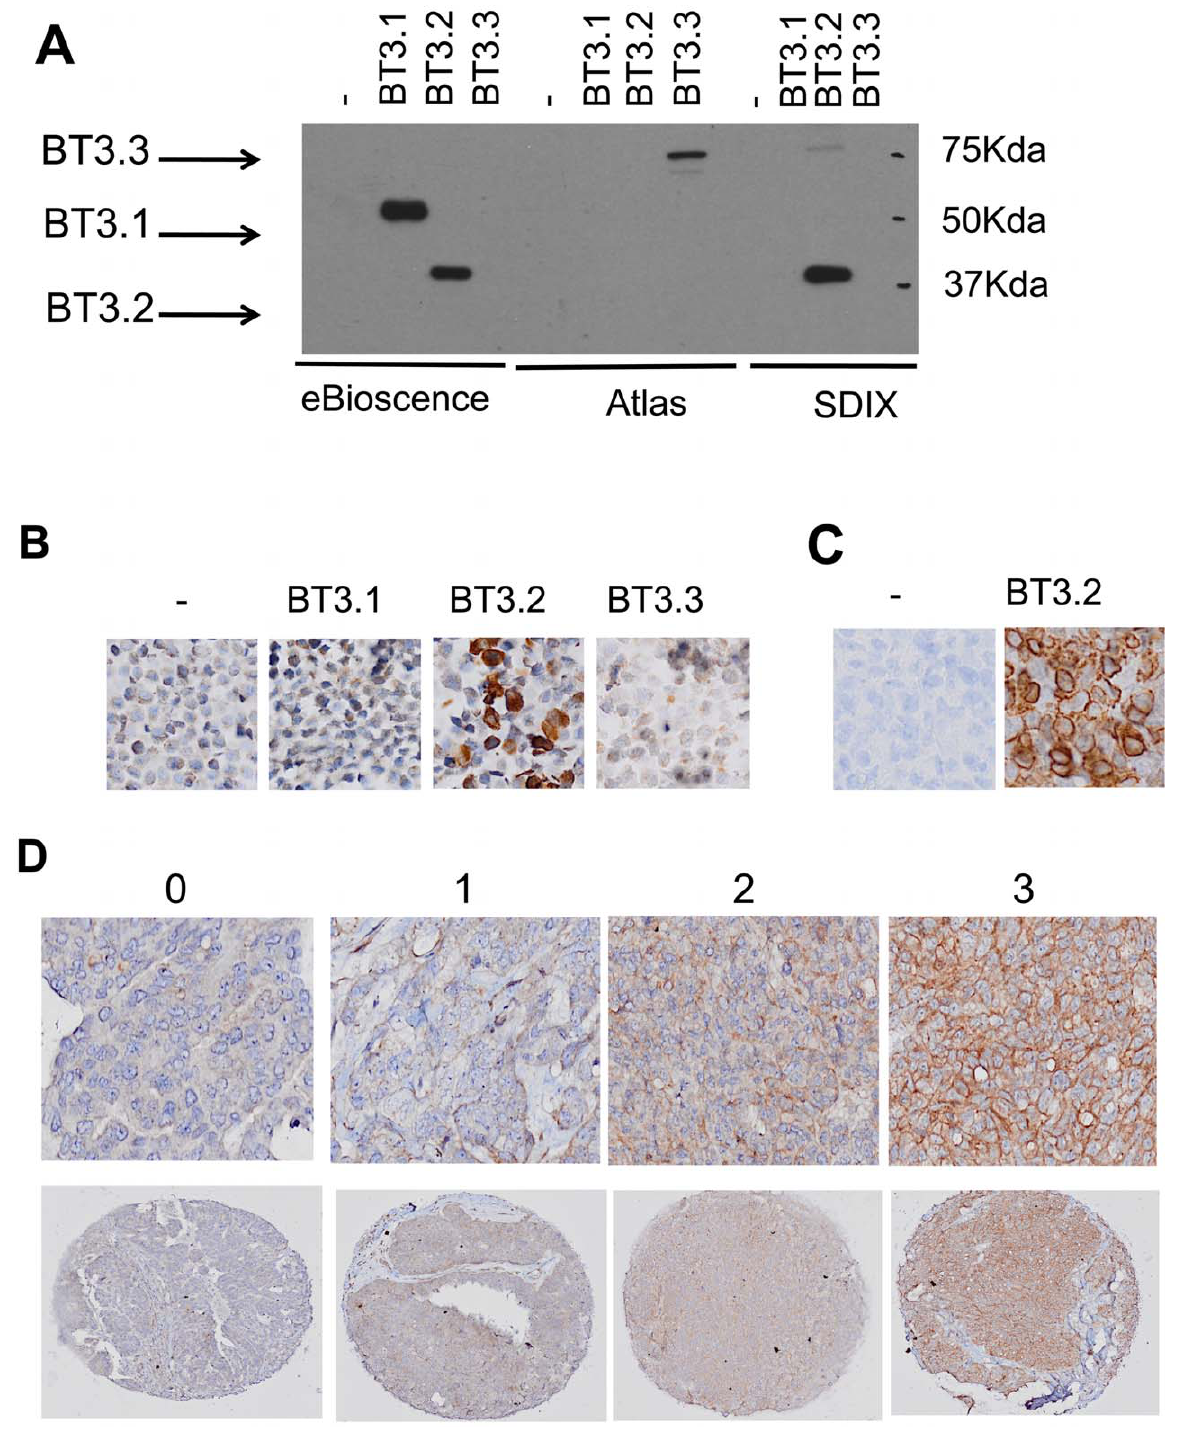
Figure 1. BT3.2 expression in ovarian cancer cells. A . Western-blot analysis of total protein extracts from TOV112D cell line infected with PLenti (vector control), BT3.1, BT3.2 or BT3.3 viral constructs. Extracts were loaded in triplicate on 10% SDS/PAGE gel and membranes were hybridized with anti-CD277 (eBioscience), anti-BT3.3 (Atlas Antibodies) and anti-BT3.2 (SDIX Inc.) as indicated at the bottom of the Figure. B . Immunohistochemistry analysis of paraffin-embedded cell pellets from TOV112D cell line infected with either PLenti (vector control), BT3.1, BT3.2 or the BT3.3 viral constructs. Only cells transfected with the BT3.2 construct stained positively with the anti-BT3.2 (SDIX Inc.). C . Immunohistochemistry of xenograft tumors from TOV112D transfected with either empty vector or BT3.2 construct. Only cells infected with the BT3.2 construct stained positively with the anti-BT3.2 (SDIX Inc.). D . Representative staining for immunohistochemistry of BT3.2 on a high-grade serous EOC TMA. From left to right: negative, low, moderate and high intensity.